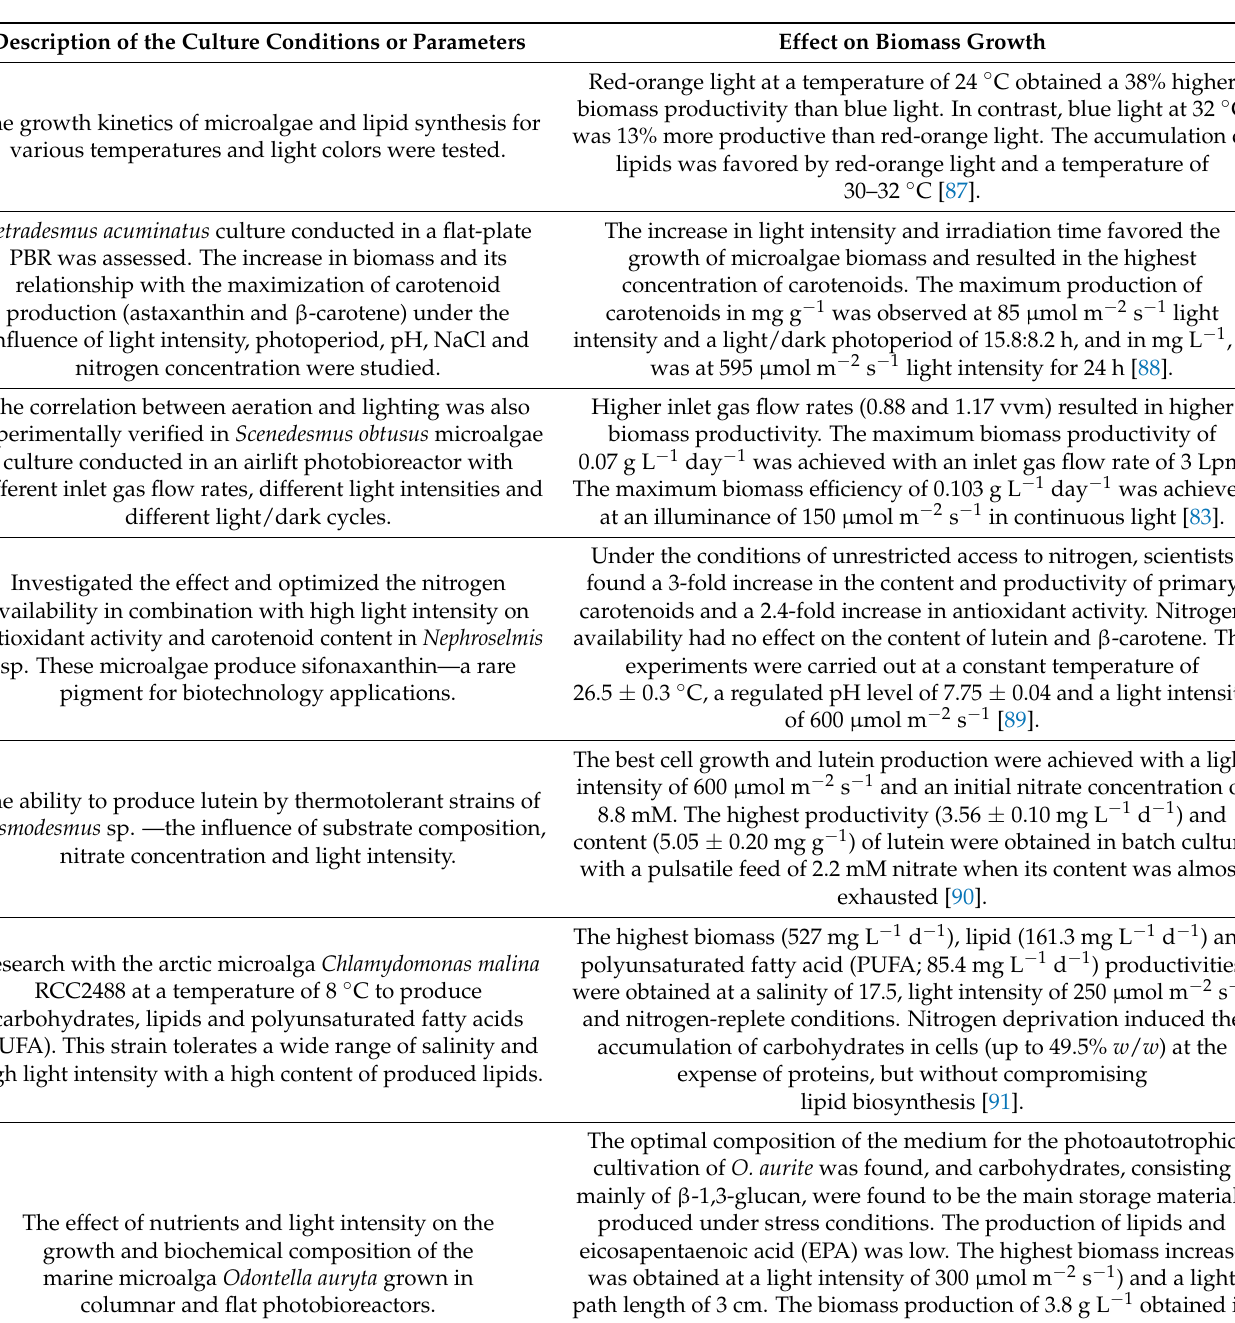
Table 8. Effects of culture parameters on efficiency of microalgae biomass